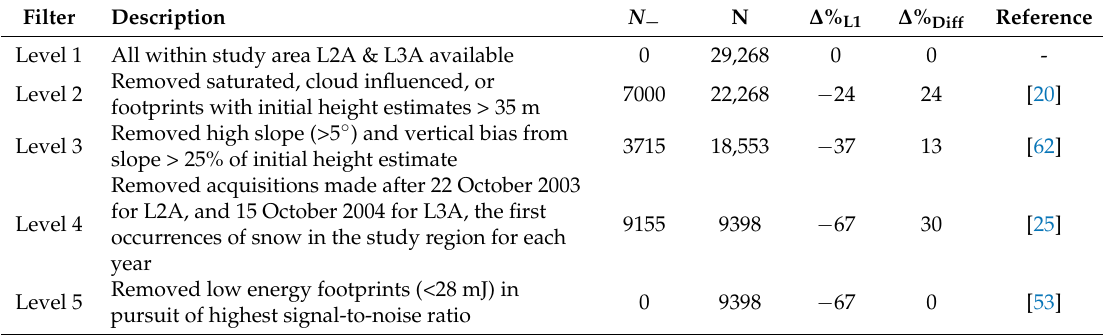
Table 1. Brief description of sequentially applied filters to GLAS footprints within the study region. The number of footprints removed (N − ) and remaining (N) after filter application, and the percent difference in the number of available footprints from filter Level 1 ( ∆ % L1 ) and between each filter ( ∆ % Diff ) are also